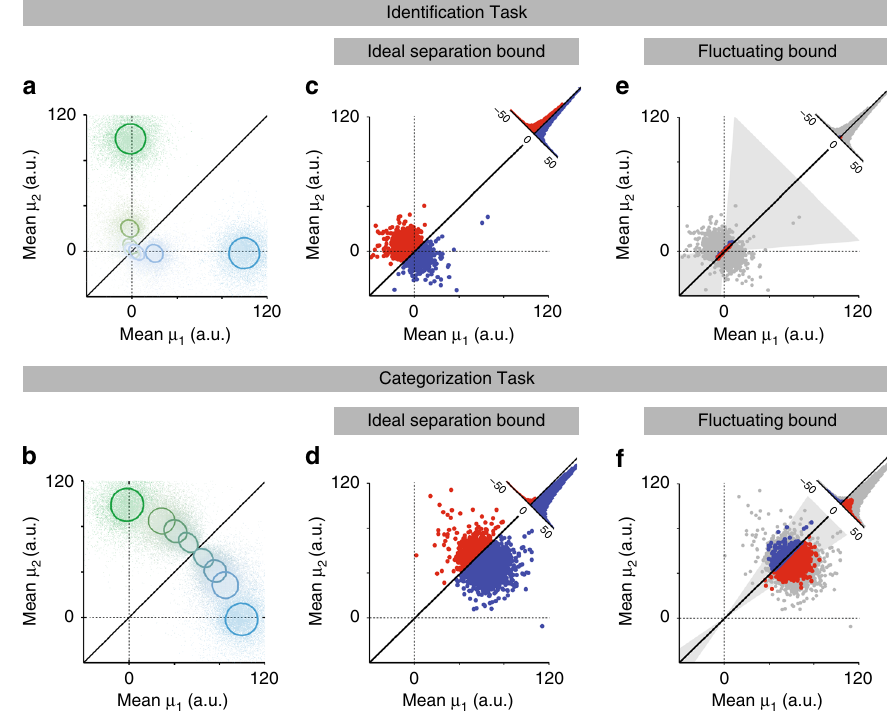
Fig. 8 Weight fl uctuations amplify errors in categorization task. a , b Stimulus space for categorization task. Each point represents a combination of inferred drift rates for a given trial in the pure DDM (with no learning) that was fi t to identi fi cation task (see Methods for more details). Solid oval lines represent the Mahalanobis distance of 1 in relation to the population average for each of the eight stimuli. Solid black line depicts the ideal classifying process: above it implies a right-side decision, below it a left. Color code for each point and line follows the same logic as Fig. 2a, b. The larger overlap of each set in the identi fi cation task ( a ) explains the performance degradation, as most points are located around the origin. For the categorization task ( b ), the lack of overlap between stimuli clari fi es the higher performance seen in Fig. 4. c , d Mean drift rates for the most dif fi cult left-decision choice for Bayes- DDM model (A > B, with correct choices always being left choices). In the case of the identi fi cation task this is the 10 − 4 /0 stimuli ( c ); for the categorization task the stimulus is the 56%/44% mixture ( d ). Blue signal the correct classi fi ed choices and red the incorrect. Considering the ideal separation bound, we show the projected histograms for the difference 〈 μ 1 〉 − 〈 μ 2 〉 . e , f Same as c , d but now with fl uctuating weights depicted as the slope of the category bound. Gray area indicates the weight fl uctuations that are equivalent to 1 standard deviation for both tasks. Blue indicates trials that were originally incorrect in c , d but became correct, and red indicates trials that became incorrect but originally correct. Light gray dots indicate answers that remained unchanged. Histograms quantify the four populations of